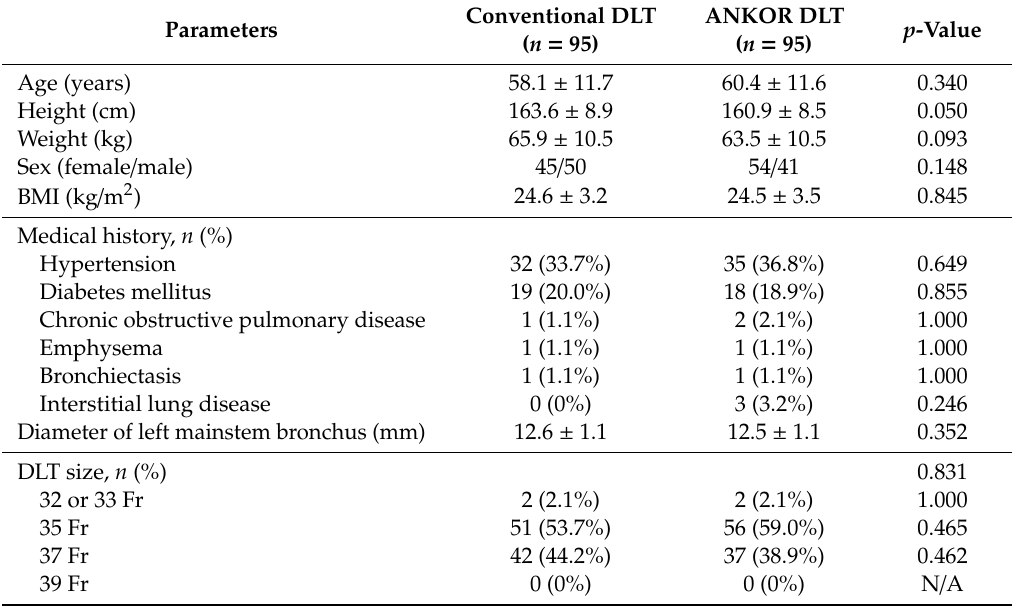
Table 1. Patients’